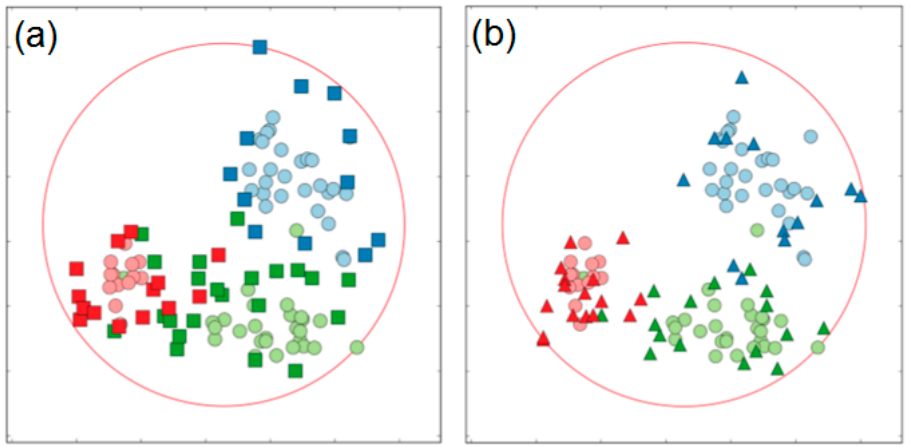
Figure 14. Adversarial prototype selection algorithm (“Student vs. Professor”) with circular domain (Wine dataset) after the last iteration. Colored balls are data samples from the original dataset. Domain boundary is shown as a red circle. Selected prototypes: ( a ) Bold squares are the prototypes selected by the professor; ( b ) Bold triangles are the prototypes selected by the student.